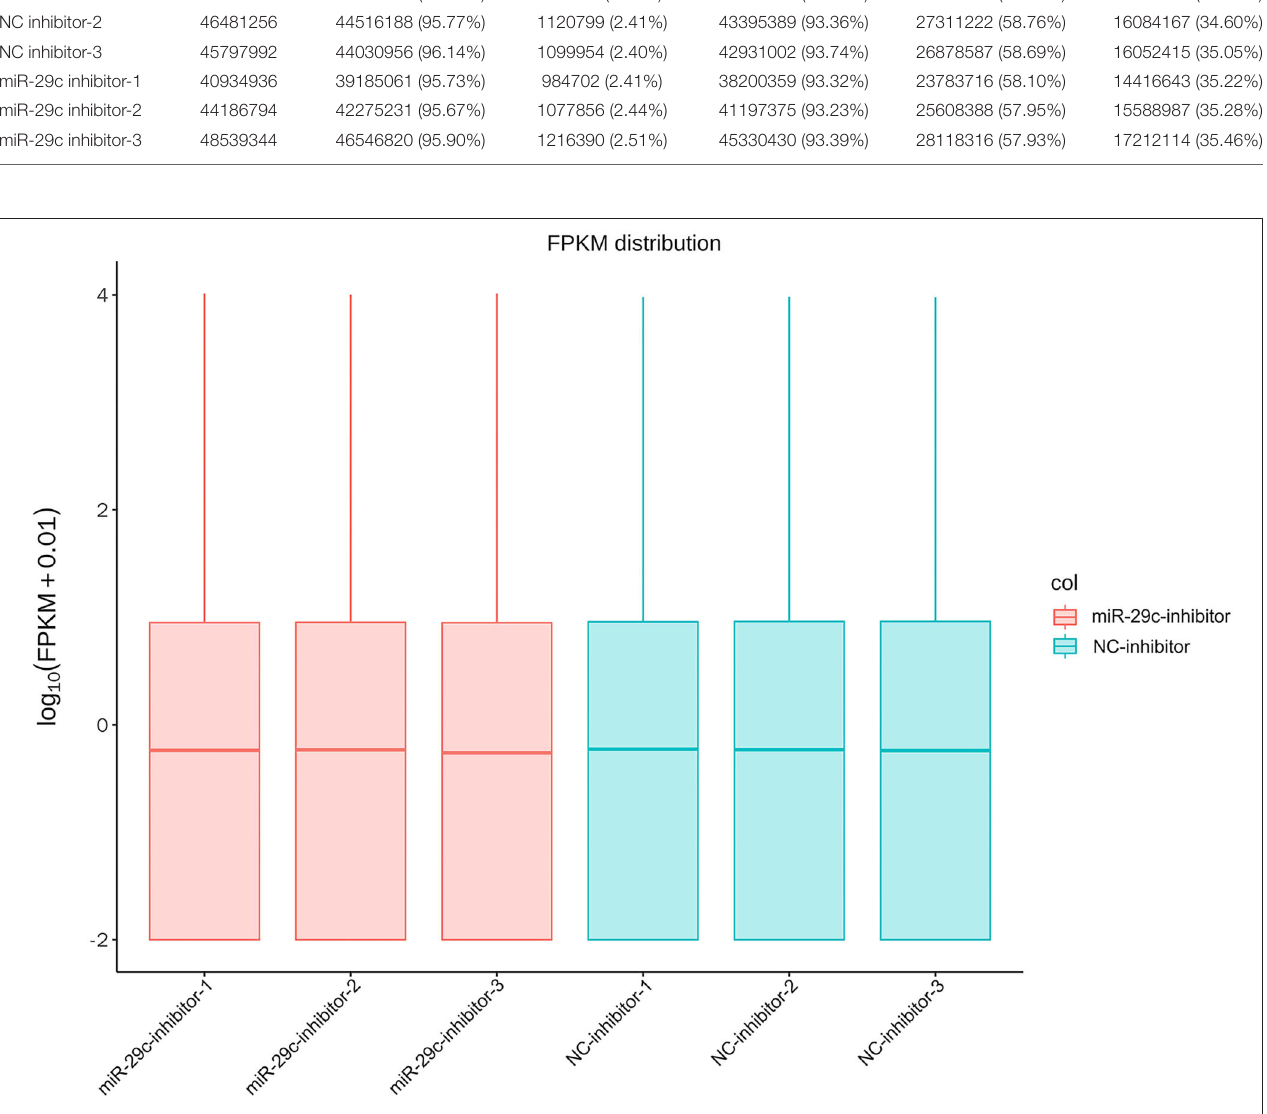
FIGURE 2 | The boxplot of expression abundance (FPKM) of genes in each